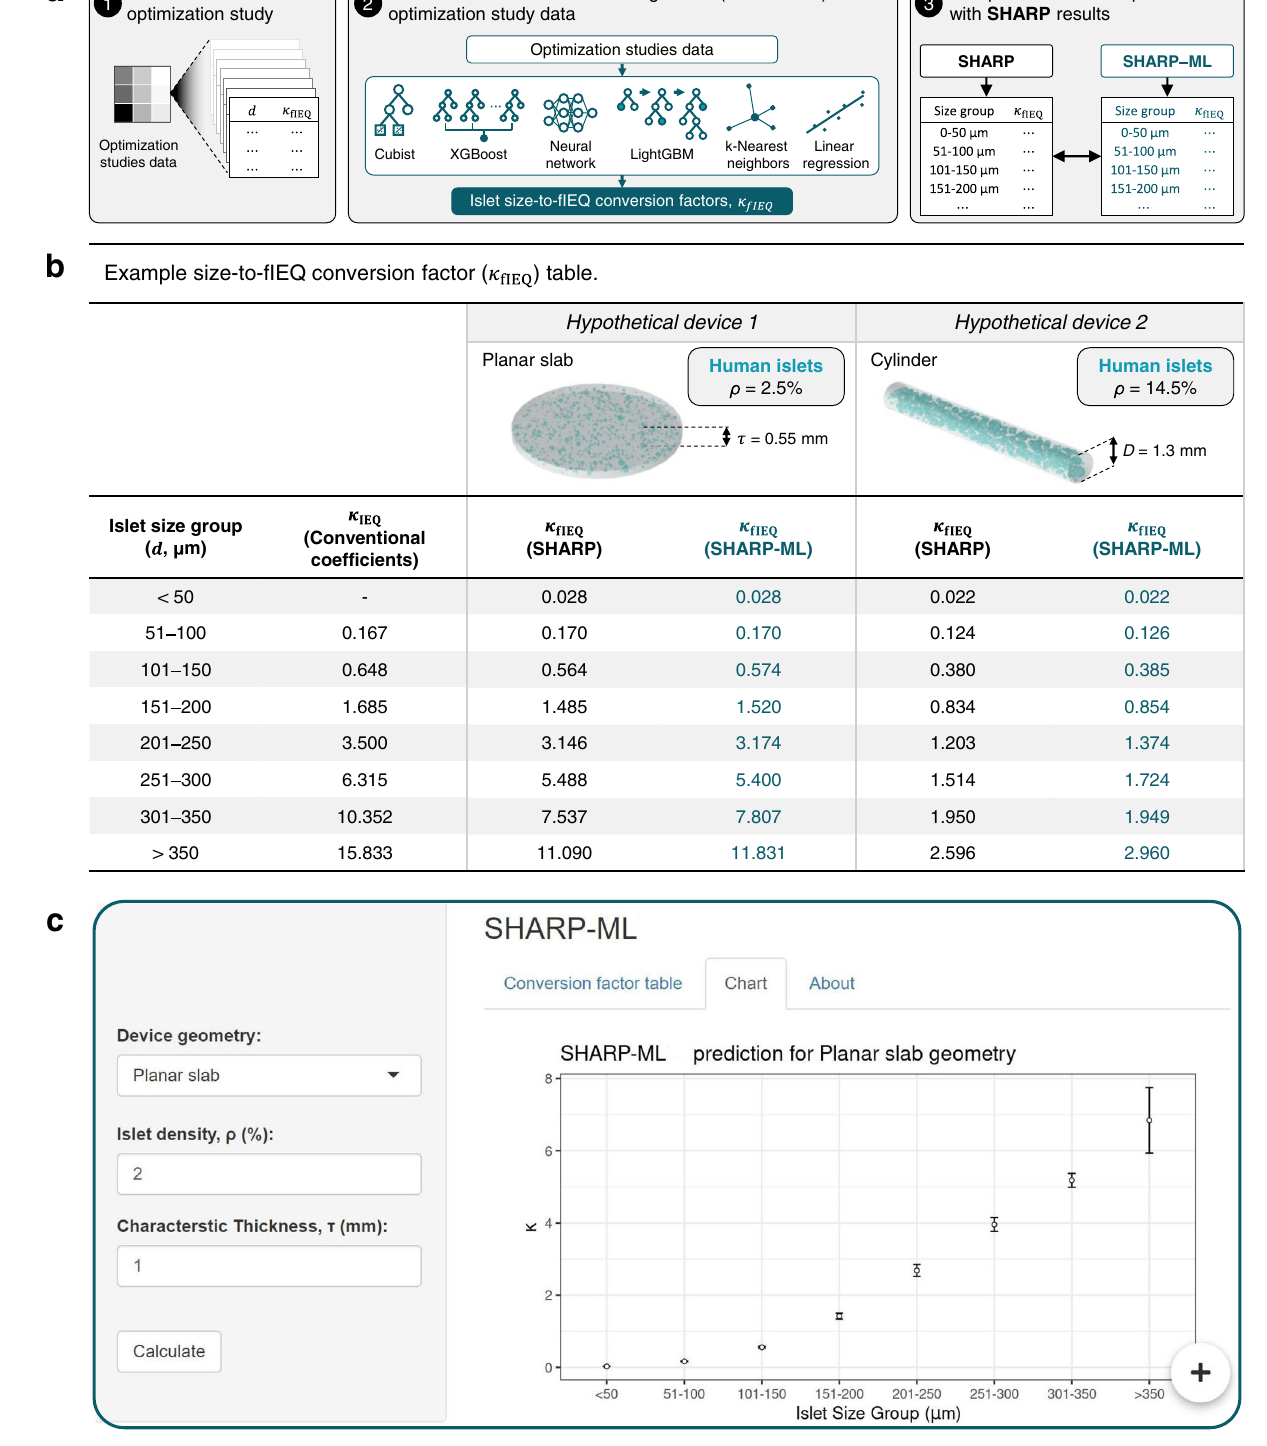
Fig.6|Ensemblemachinelearningmodelachievesrapidpredictionoffunction adjusted IEQ conversion coef fi cients. a Procedure for developing and validating ensemble machine learning model (SHARP-ML) to predict size group-to-fIEQ con- version coef fi cients ( κ fIEQ ): (1) individualislet results from the optimizationstudies (Fig.5)werecollected;(2)anensembleofmachinelearningmodelsweretrainedto subsets of the optimization studies data, producing κ fIEQ coef fi cients according to results from each constituent model weighted by Pearson ’ s correlation, r , to the training data; (3) SHARP-ML predictions were cross-validated with SHARP calcula- tions for hypothetical encapsulation systems not included in the training dataset.